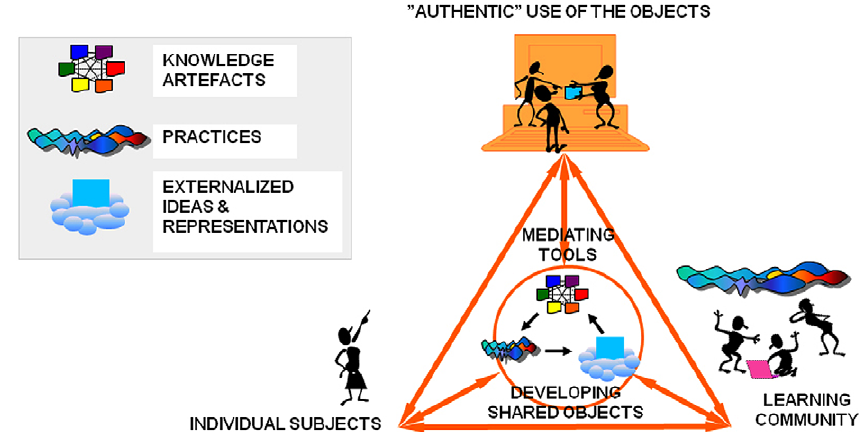
Figure 1. An illustration of the trialogical approach on learning presenting its basic elements. Source: Paavola and Hakkarainen